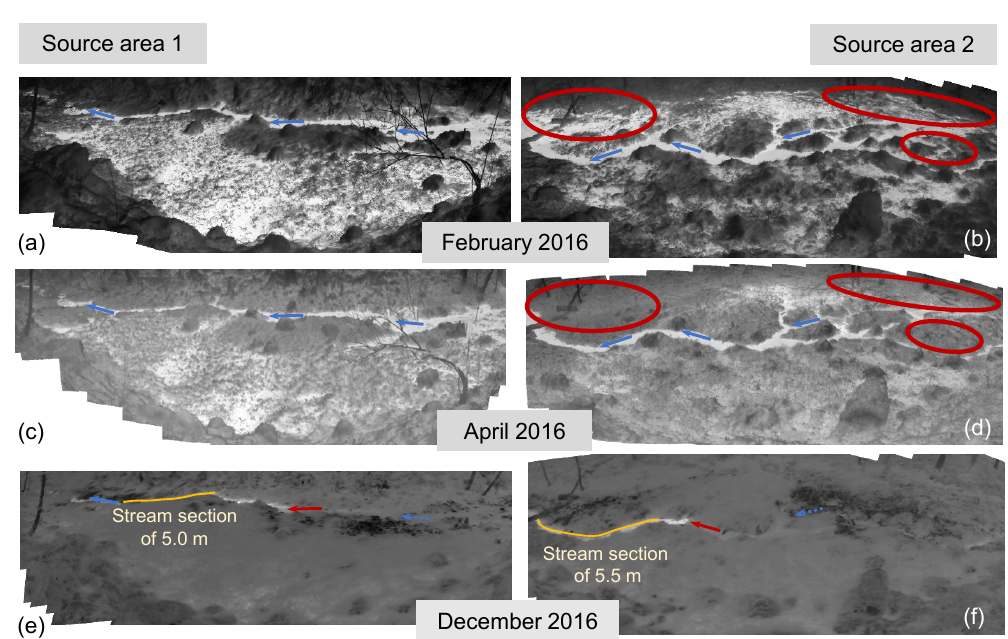
Figure 6. Transition of two source areas ( a , c , e vs. b , d , f ) from very wet ( a , b ) to very dry conditions ( e , f ). Surface saturation in source area 1 ( a , c , e ) barely changed between February and April 2016, whereas source area 2 is clearly drier at some locations (red ovals) in April 2016. In December 2016, both source areas were completely dry on each side of the stream (blue arrows represent flow direction), and the stream started further downstream (red